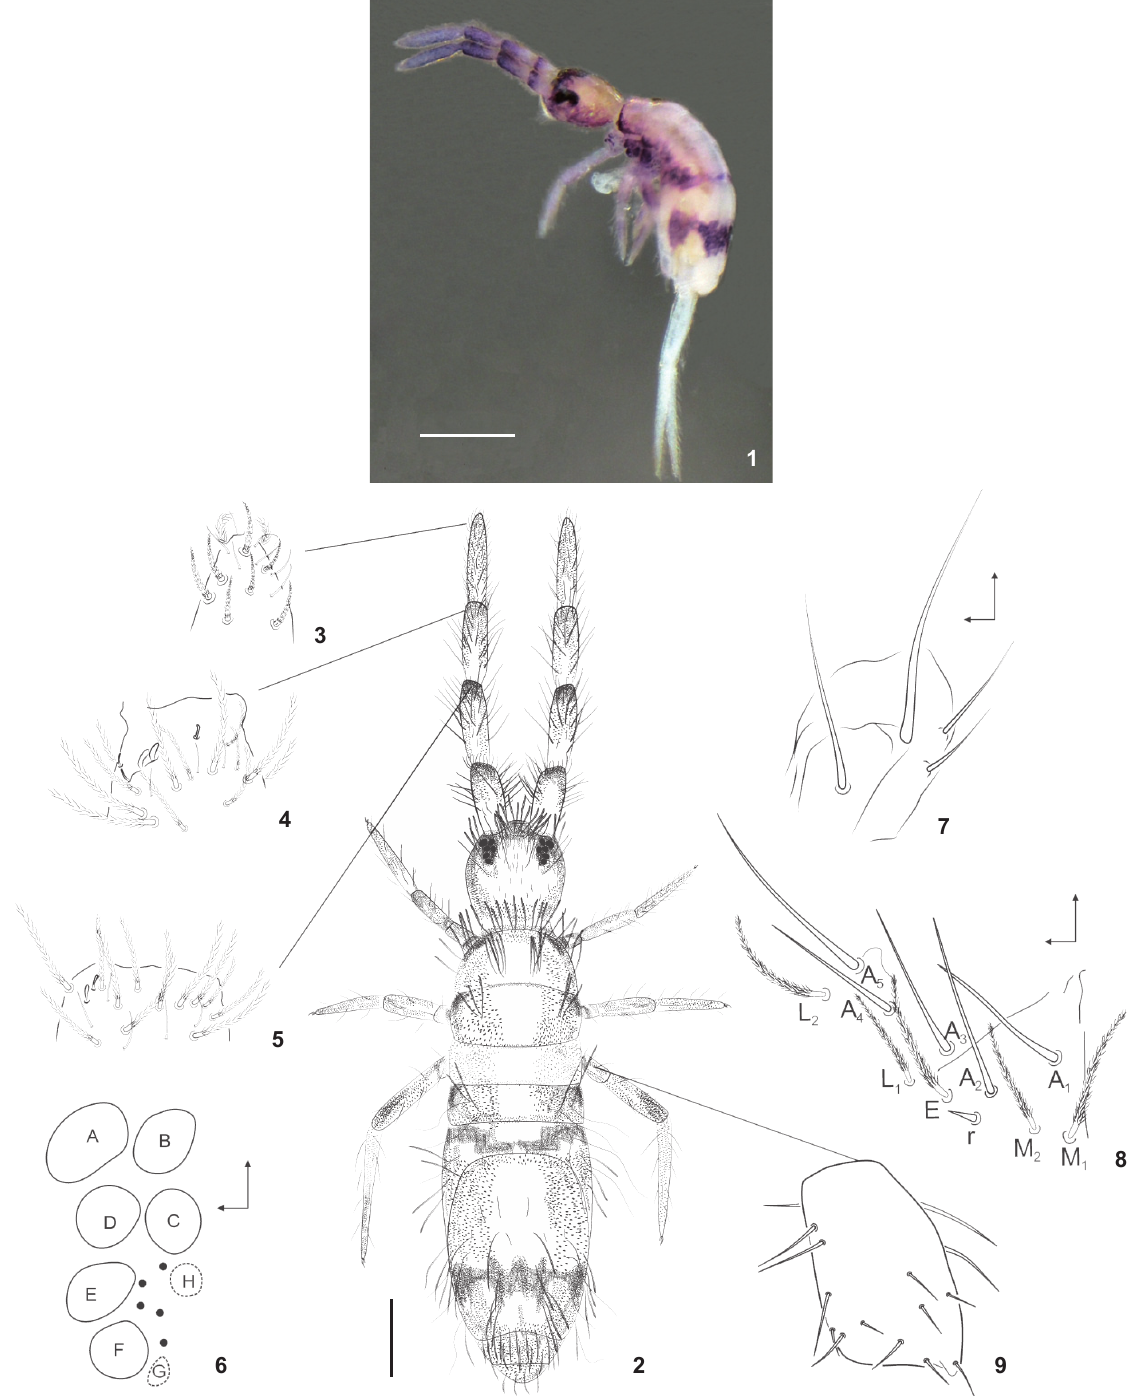
Figure 1-9. Trogolaphysa formosensis sp. nov. : (1) habitus of a fixed specimen in ethanol, lateral view; (2) habitus (dorsal view); (3) apical region of Ant IV (right); (4) apical region of Ant III (right); (5) apical region of Ant II (right); (6) eye patch (left); (7) maxillary palp and sublobal plate (left); (8) labial triangle chaetotaxy (left); (9) metatrochanteral organ. Scale bars: 0.2